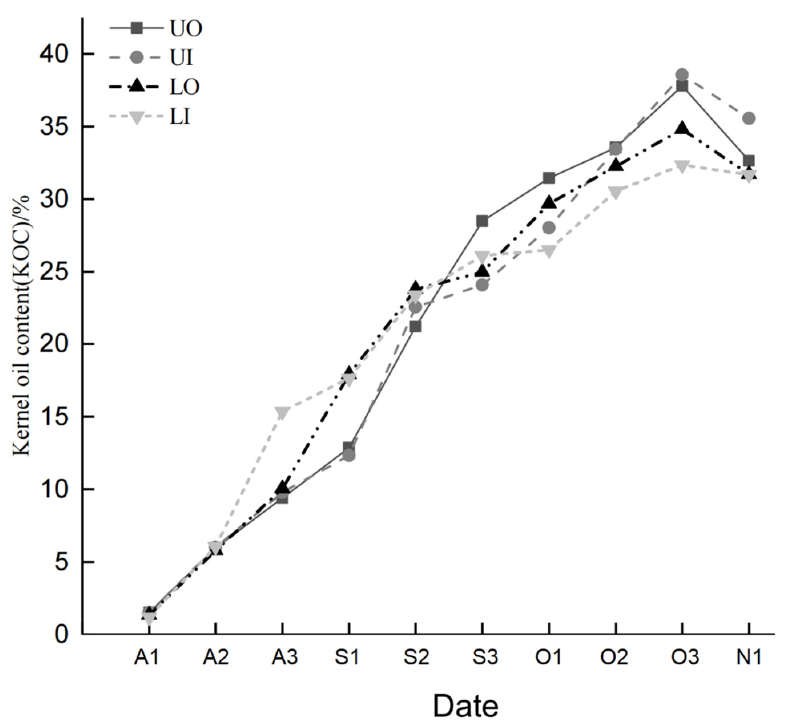
Figure 5. Kernel oil content in C. oleifera ‘Huaxin’ from August 2021 to November 2021. At the end of the oil accumulation phase, the fatty acid composition of C. oleifera was found to majorly comprise oleic acid (76–78%), followed by linoleic acid, palmitic acid, stearic acid, linolenic acid and cis-11-dodecenoic acid (Figure 6). Except for the significant decrease in palmitic acid from S2 to N1, no significant change was shown in other acids, and there was no significant difference in fatty acid content among the four canopy posi- tions. A